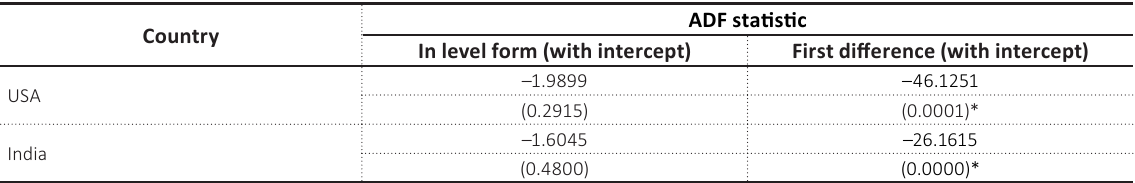
Source: Calculated by authors based on the stock price indices for two countries. ADF